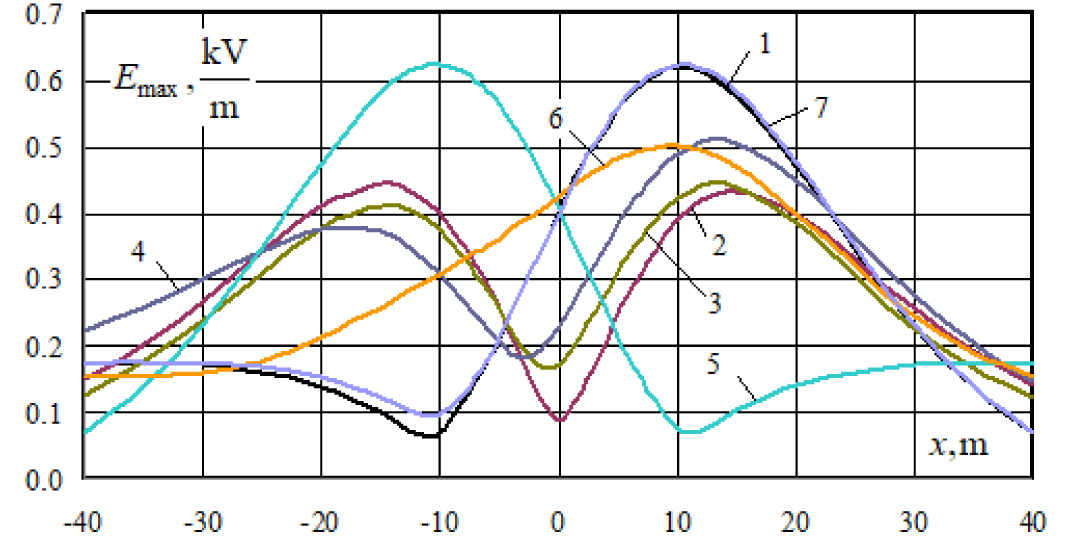
Figure 16. Amplitudes of electric field strength at the beginning of the first section of the three-circuit line as a function of the coordinate x by phase sequence